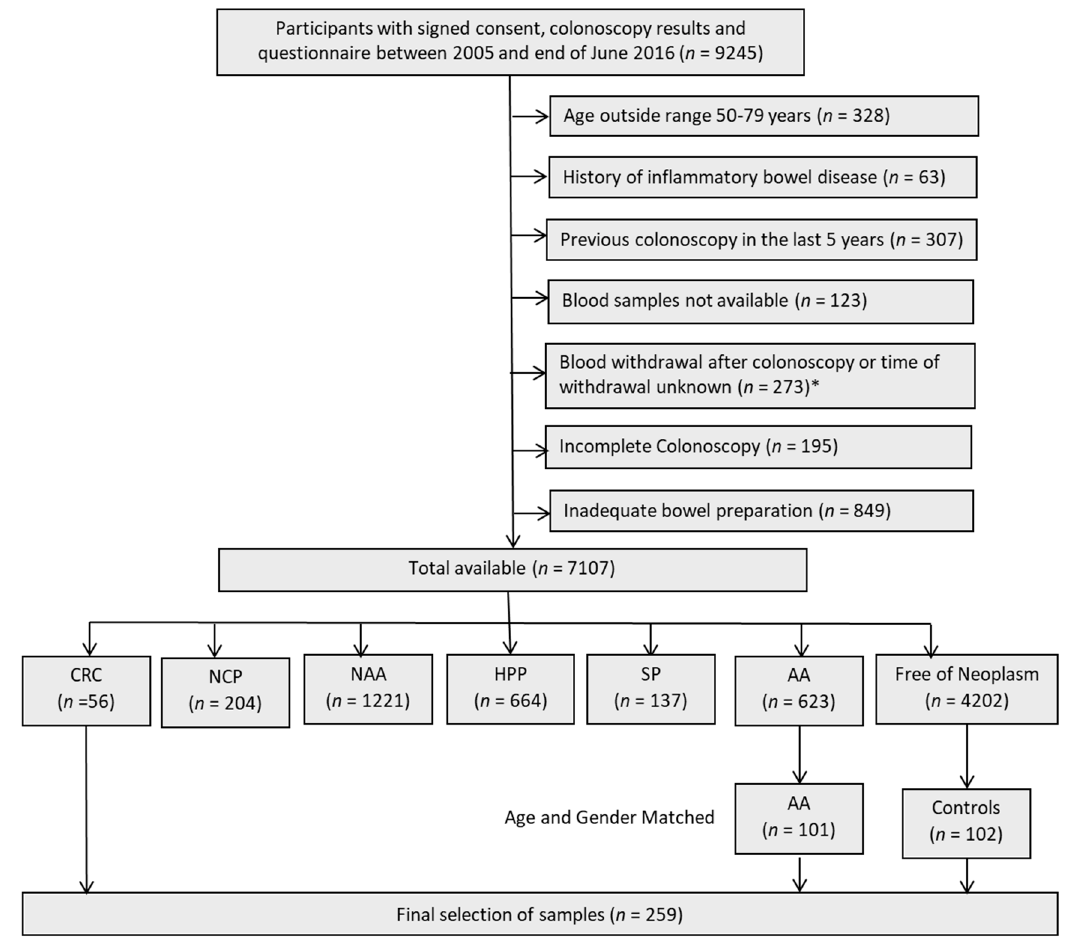
Figure 2. STARD (Standards for Reporting of Diagnostic Accuracy) flow diagram of the BLITZ Study.